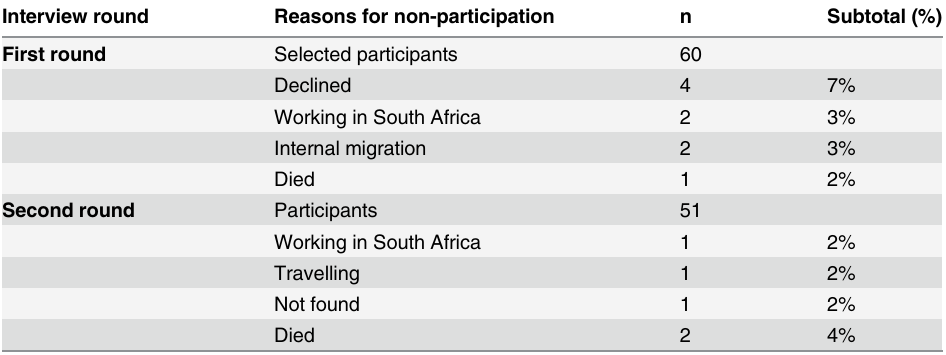
Table 1. Reasons for